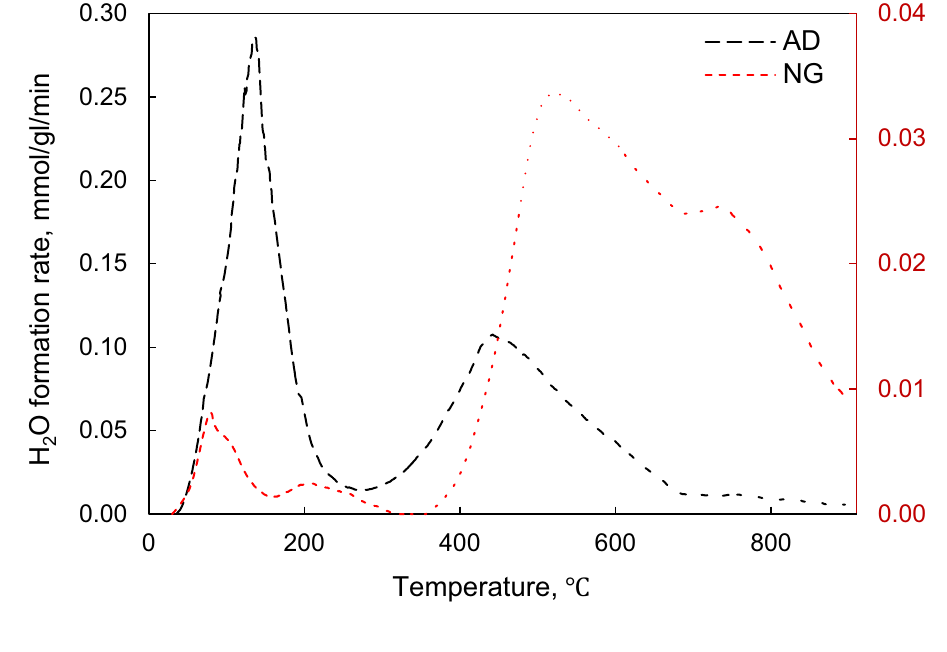
Fig. 10 H 2 O evolution rates as a function of temperature for coal AD and